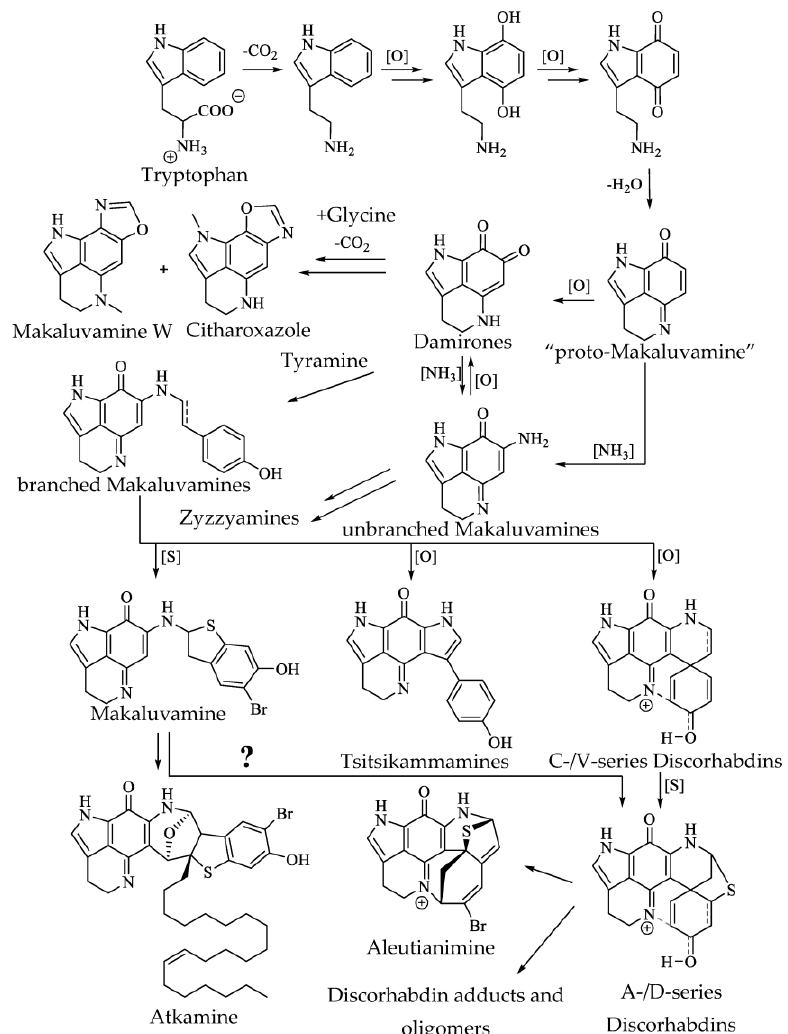
Figure 6. Putative biosynthetic pathway of pyrroloiminoquinones. Adapted from references [1 – Figure 6. Putativebiosyntheticpathwayofpyrroloiminoquinones. 4,53,84,85].